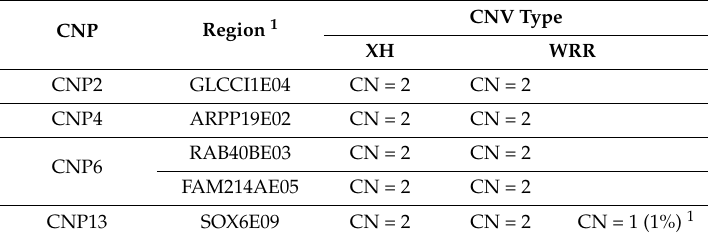
Table 6. The result of the AccuCopy ® assay.